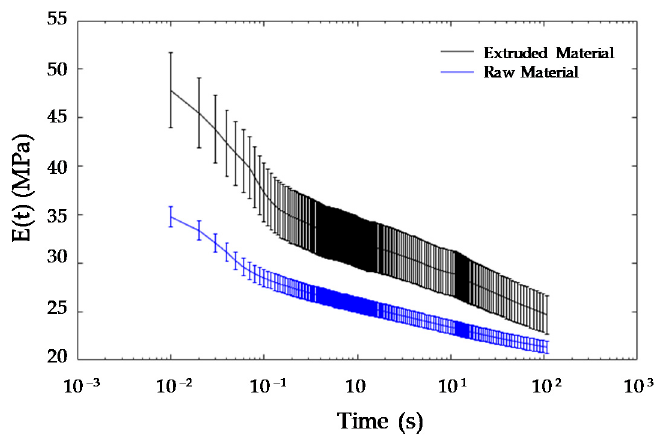
Figure 6. Relaxation curves obtained for the tested filaments.